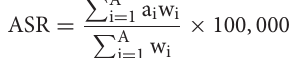
( Figure 1B and Supplementary Table 3 ). Decreasing HIV/AIDS trends were observed in both sexes ( Supplementary Table 3